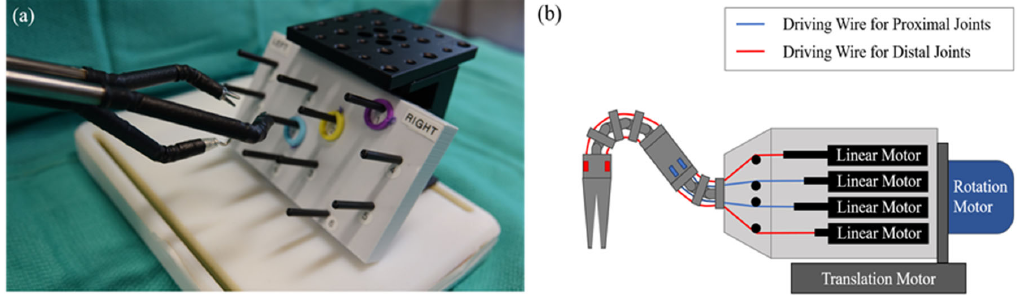
Figure 1. Wire ‐ driven surgical robot with joint structure: ( a ) suturing test of prototype; ( b ) conceptual diagram of working principle.